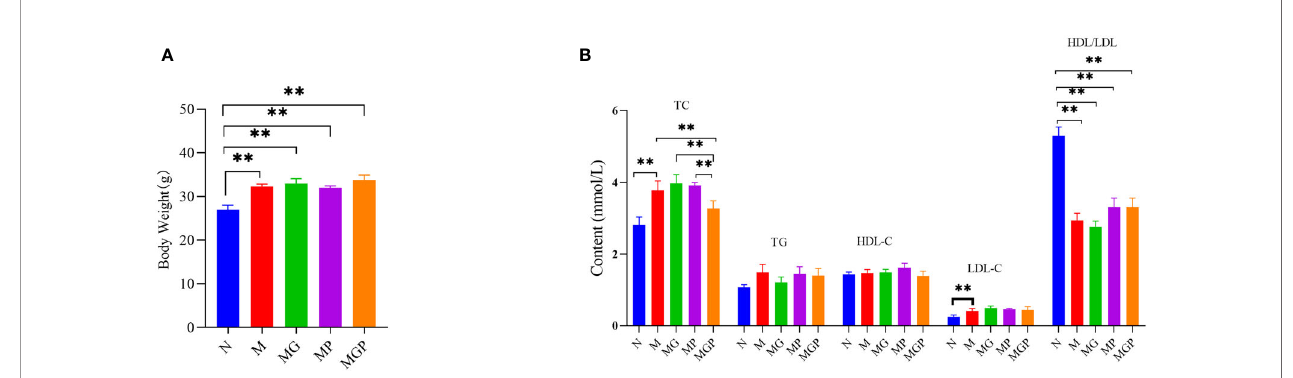
FIGURE 3 | Effects of live culture of Enterococcus faecium and Bacillus subtilis (LCBE) and galacto-oligosaccharides (GOS) on body weight (A) and plasma metabolites (B) in mice. N represents the group of mice fed with a standard diet; M represents the group of mice fed with the high-fat diet; MG represents the group of mice fed with the high-fat diet and GOS; MP represents the group of mice fed with the high-fat diet and probiotic mixture; MPG represents the group of mice fed with the high-fat diet, GOS and probiotic mixture. **Indicates signi fi cant difference compared with M group ( P <